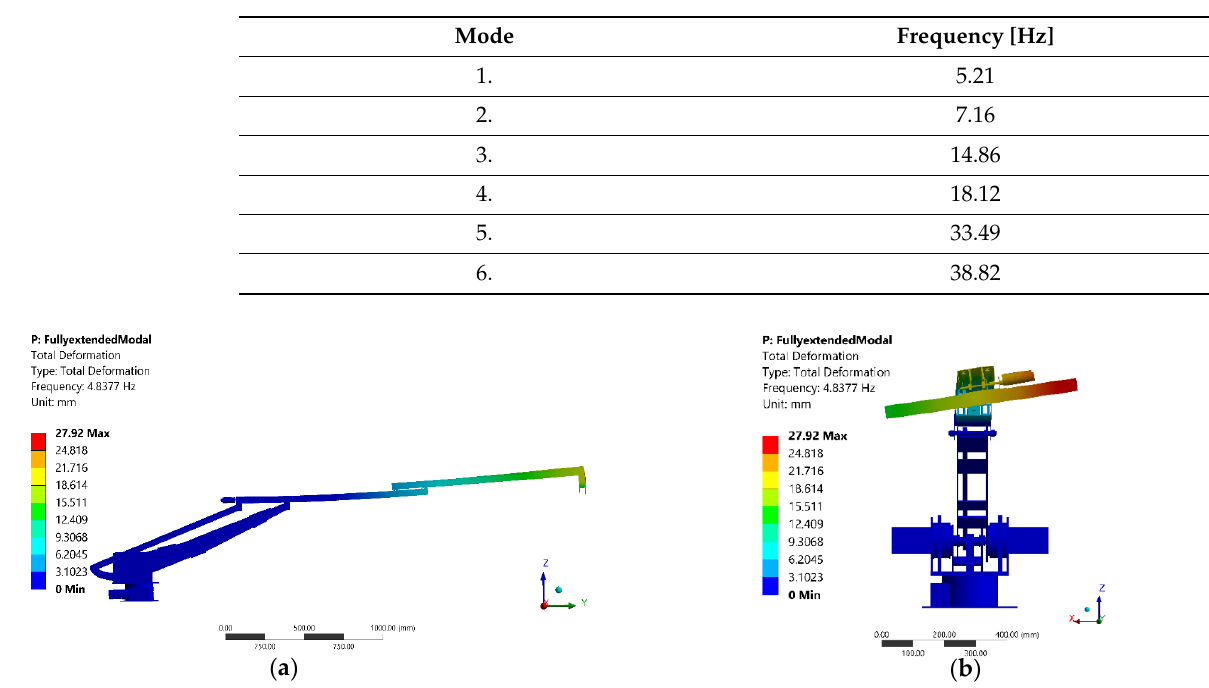
Figure 6. The 1st mode shape of vibration for the Fully-extended configuration, arm is fixed at the base ( a ) side view & ( b ) front